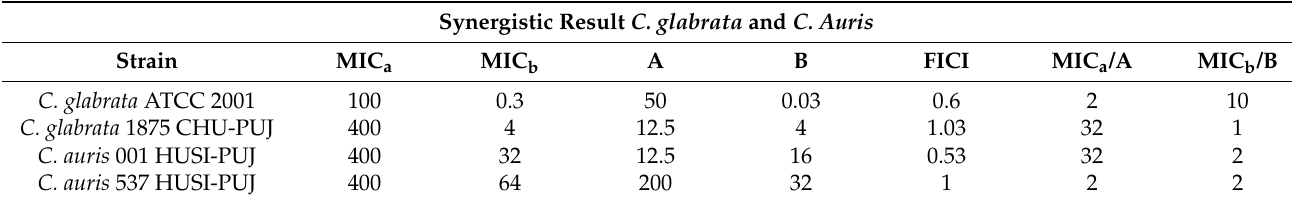
Table 5. Effect of combining the C6 chimeric with FLC on C. glabrata and C. auris strain. Synergistic Result C. glabrata and C.